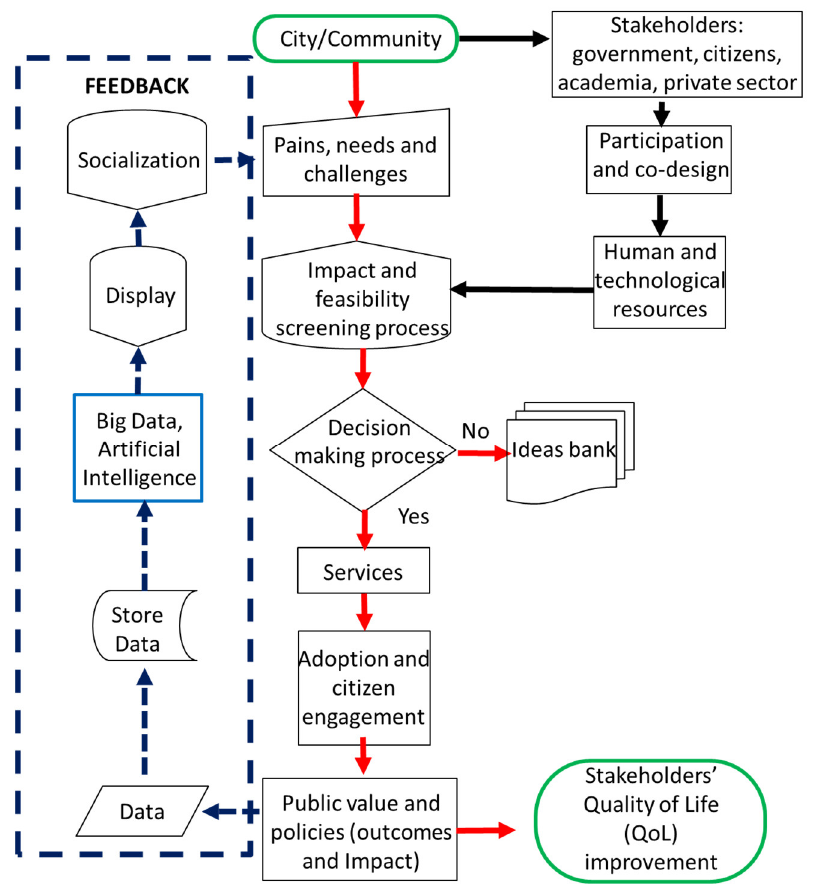
Figure 1. Logical framework of a Smart City.